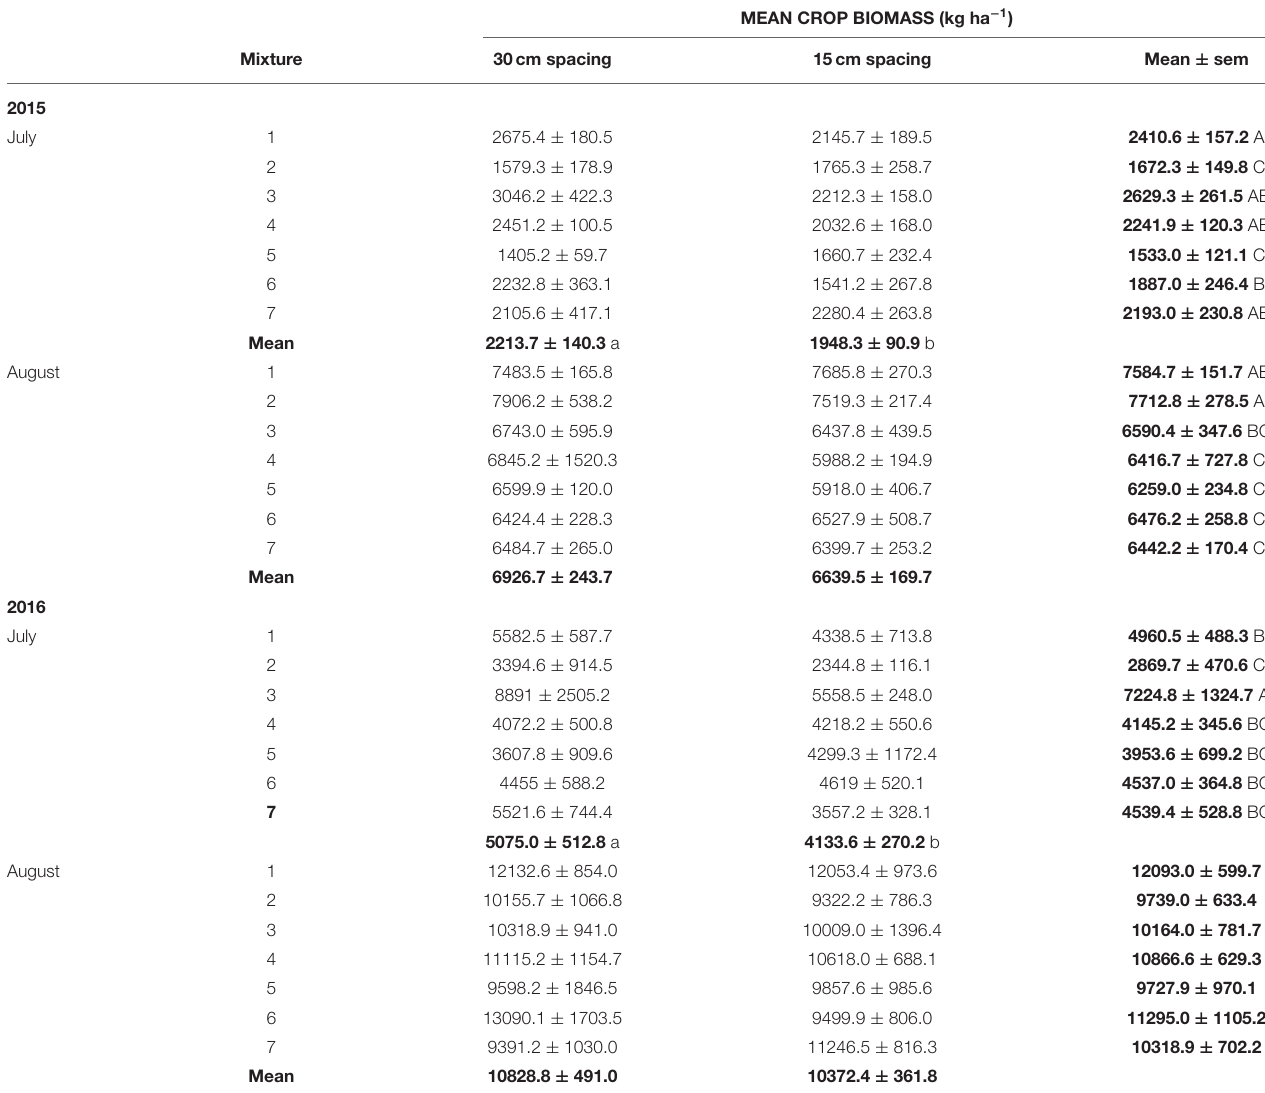
TABLE 5 | Mean crop biomass by crop mixture treatment and row spacing (see Table 1 for list of cropping treatments) in July and August, from the 2015 and 2016 field